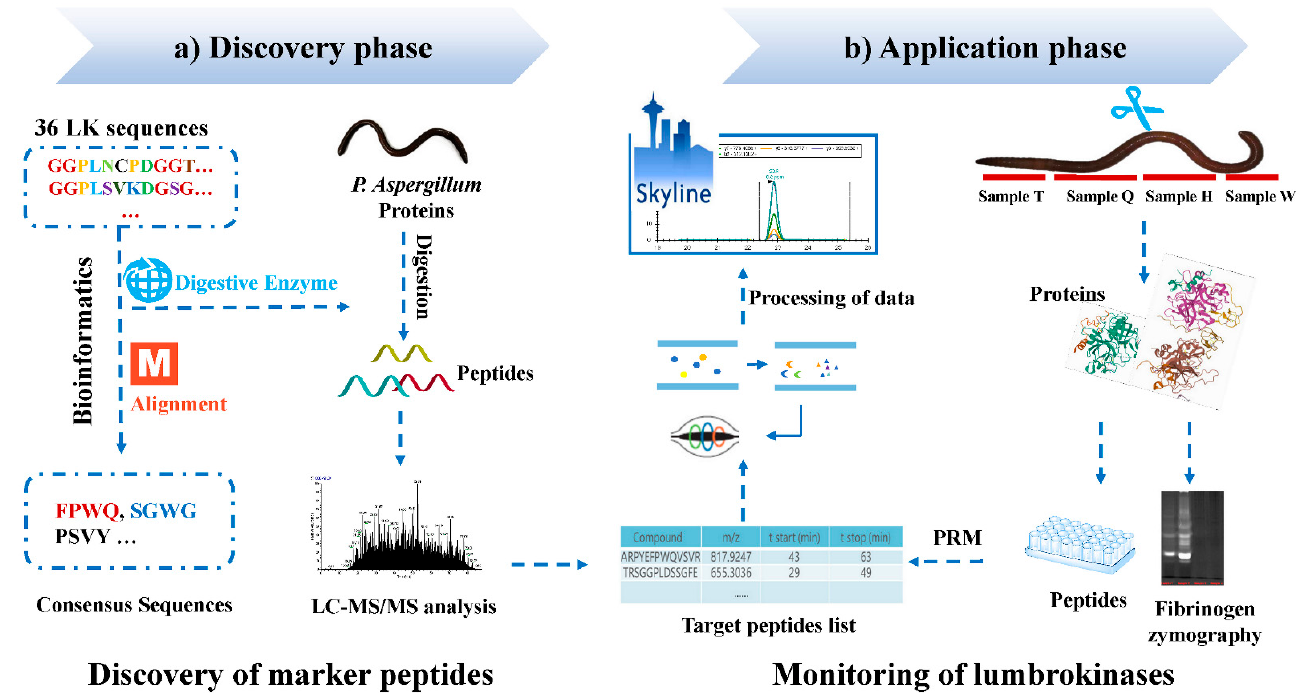
Figure 1. Scheme for rapid discovery of LKs and marker peptides from P. aspergillum . ( a ) Discovery phase: discovery of potential marker peptides based on bioinformatics tools. ( b ) Application phase: validation and evaluation of potential marker peptides representing pheretima fibrinolytic activity by PRM combined as well as fibrinogen zymography.